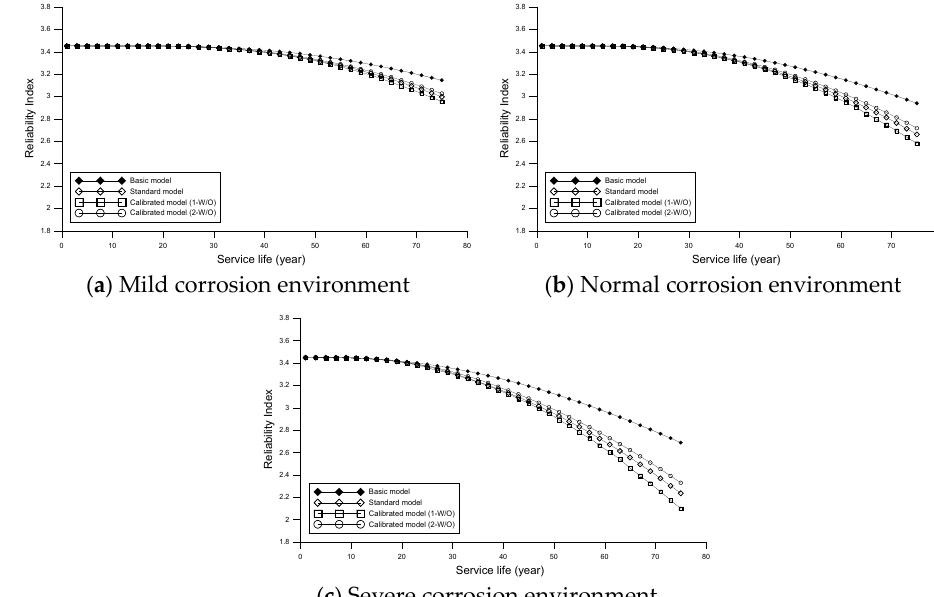
Figure 12. Reliability degradation under normal traffic characteristics (without previous inspection).